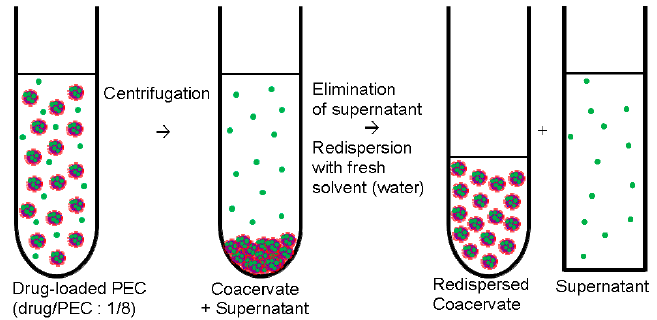
Figure 2. Centrifugation and redispersion of polyelectrolyte complex (PEC) particles (centrifugation procedure).